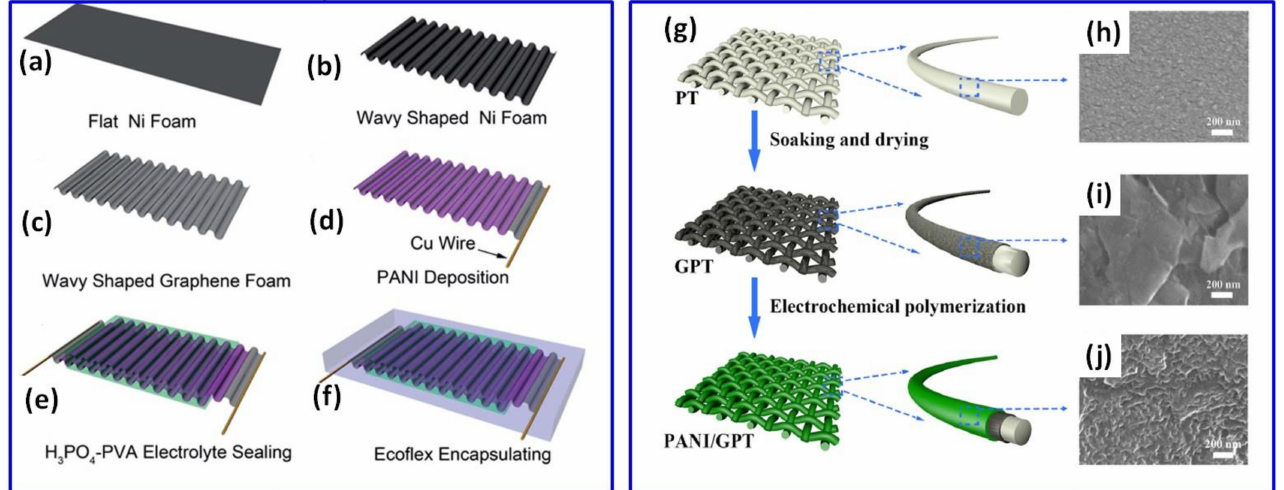
Figure 2. Schematic description of stretchable supercapacitor fabrication: flat Ni foam ( a ), wavy- shaped Ni foam ( b ), preparation of porous graphene in a wave shape by using Ni foam as a catalyst ( c ), deposition of PANI onto porous graphene via pulsed electrochemical deposition ( d ), coating with H 3 PO 4 -PVA gel electrolyte ( e ) and encapsulation of supercapacitor in elastomeric Ecoflex ( f ) (Reprinted from [51] with permission of RSC Publishing). Schematic illustration for the preparation of PANI/GPT textile electrode ( g ), microstructures of polyester textile (PT) ( h ), PT covered by graphene (GPT) ( i ) and PANI/GPT ( j ) (Reprinted from [53] with permission of Wiley).